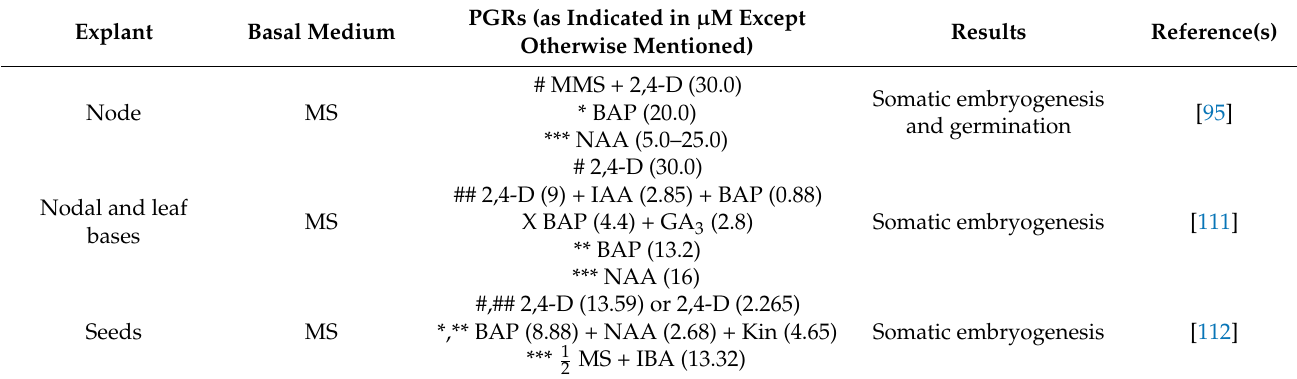
Table 2. The successful micropropagation of D. asper through somatic embryogenesis.